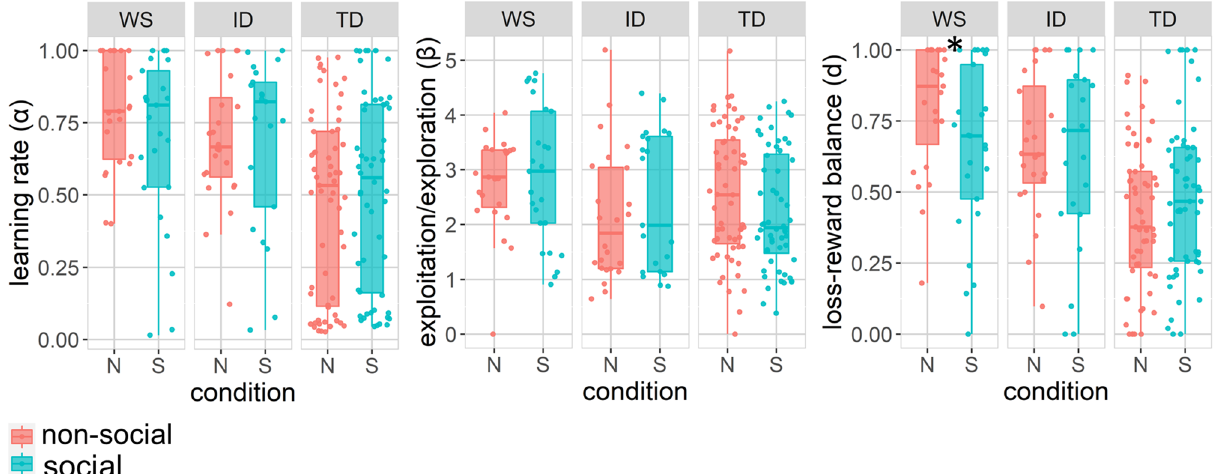
Figure 3. Differences between the social (S) and non-social (N) conditions computational modeling parameters by group. Stars indicate significant differences between conditions (paired samples t-test, Bonferroni-corrected for multiple comparisons). Boxplots cover means and 25–75th percentile. *p < 0.05. Colored dots show individual participant